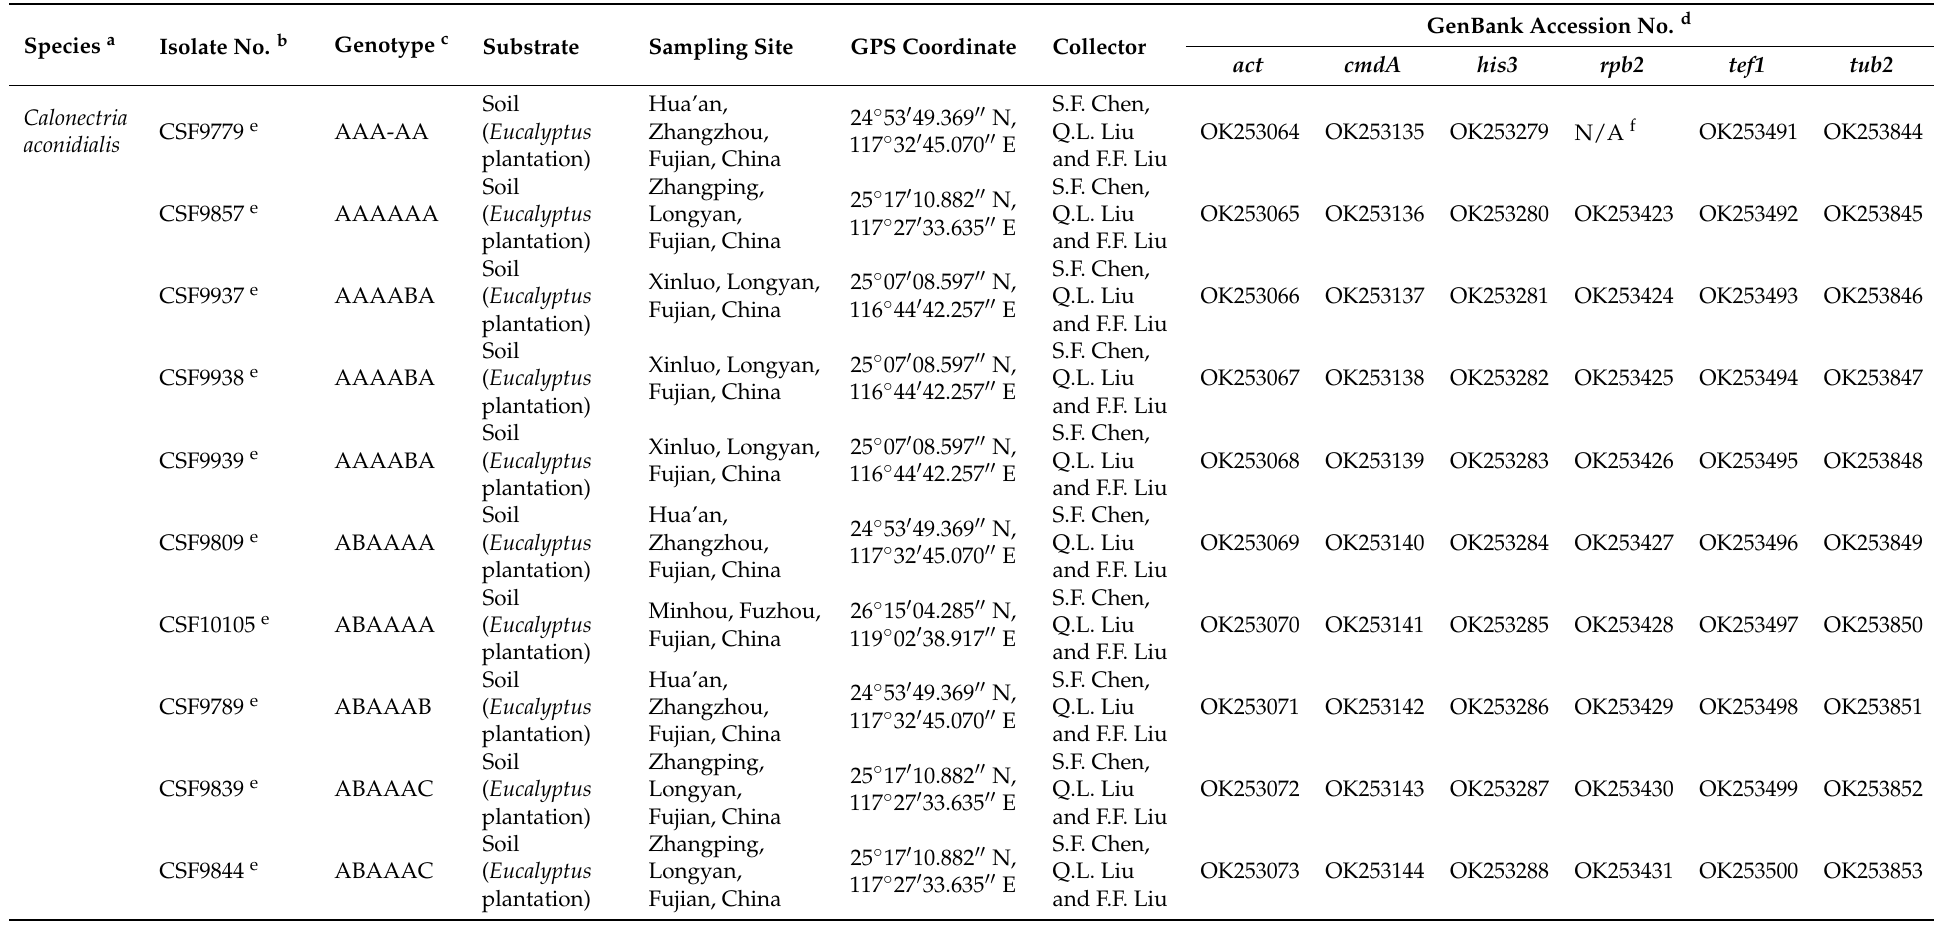
Table A1. Species of Calonectria collected in this